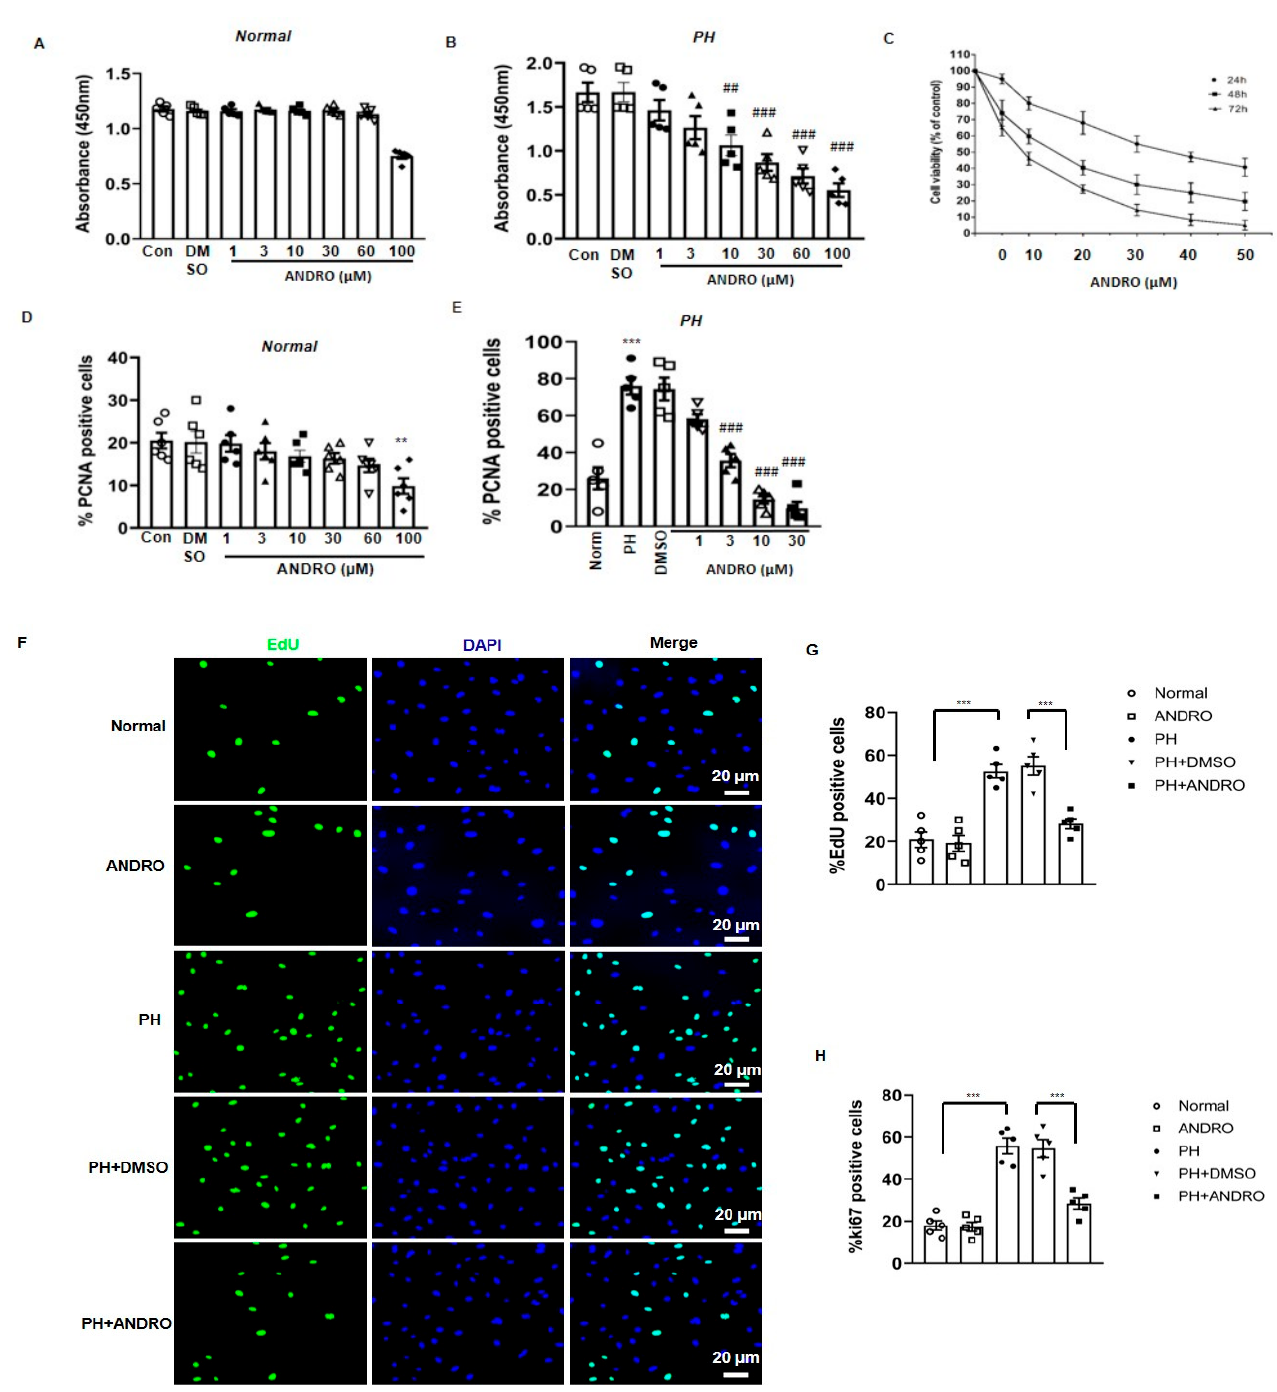
Figure 3. ANDRO reduced cell viability and proliferation of pulmonary artery smooth muscle cells from PH patients (PH-PASMCs). ( A , B ) Treatment with ANDRO for 24 h only significantly reduced cell viability of normal PASMCs at 100 µ M , but caused a significant reduction in PAH-PASMCs at the concentration range of 1–100 µ M. ( C ) The dose- and time-dependent effects of ANDRO on cell viability of PH-PASMCs. ( D , E ) Treatment with ANDRO for 24 h only significantly reduced cell proliferation of normal PASMCs at 100 µ M , but produced obvious effect in PH-PASMCs starting from 1 to 100 µ M. ( F , G ) Representative EdU staining ( F ) and group data ( G ) showing that ANDRO treatment (30 µ M, 24 h) reversed PH-PASMCs proliferation. ( H ) Ki67 staining assay showing that ANDRO (30 µ M, 24 h) reversed PH-PASMCs proliferation. Mean ± SEM, n = 5. ** p < 0.01, *** p < 0.001 vs. normal; ## p < 0.01, ### p < 0.001 vs.